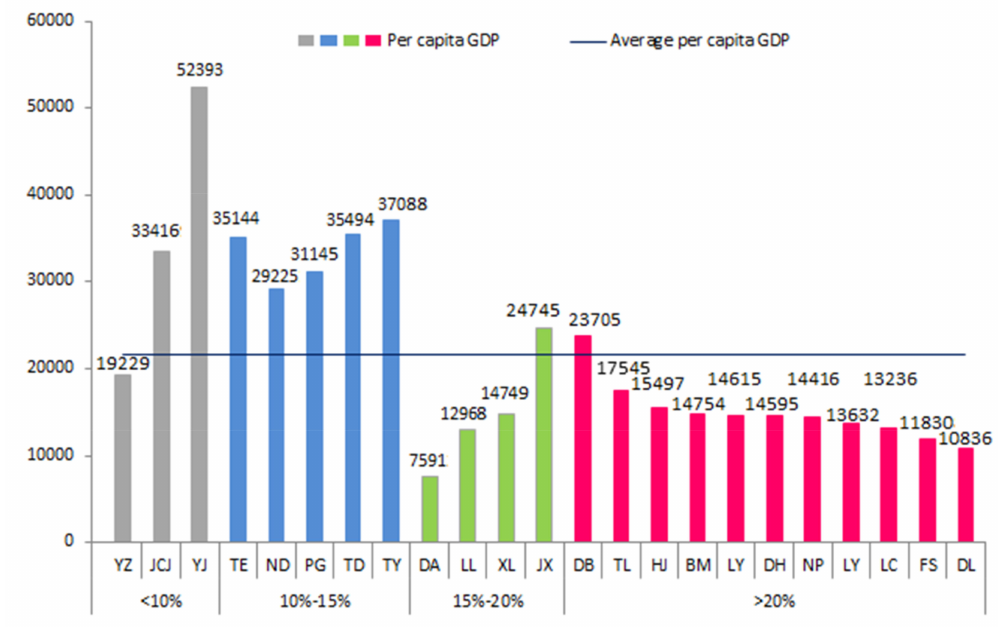
Figure 4. Per capita GDP of poverty-stricken counties in northwestern Guangxi.